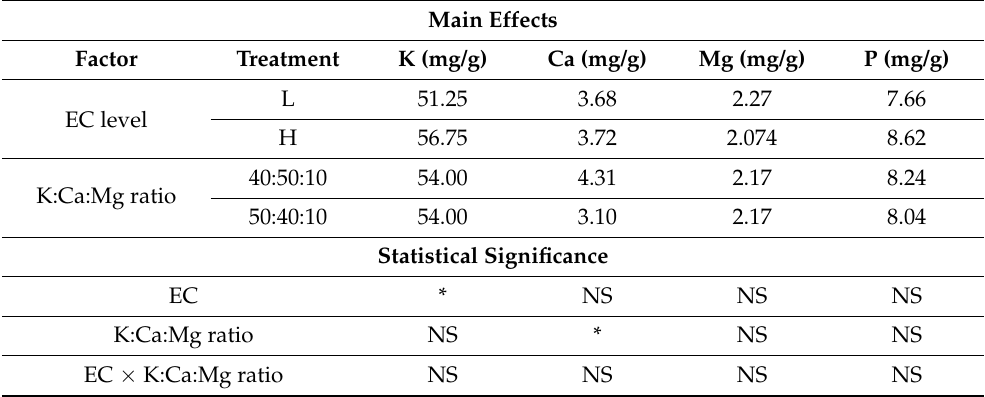
Table 3. Impact of different EC levels (low and high, as L and H, respectively) and K:Ca:Mg ratios (40:50:10 and 50:40:10) on the concentration of macronutrients (K, Ca, Mg and P) in leaf tissues of hydroponically grown spiny